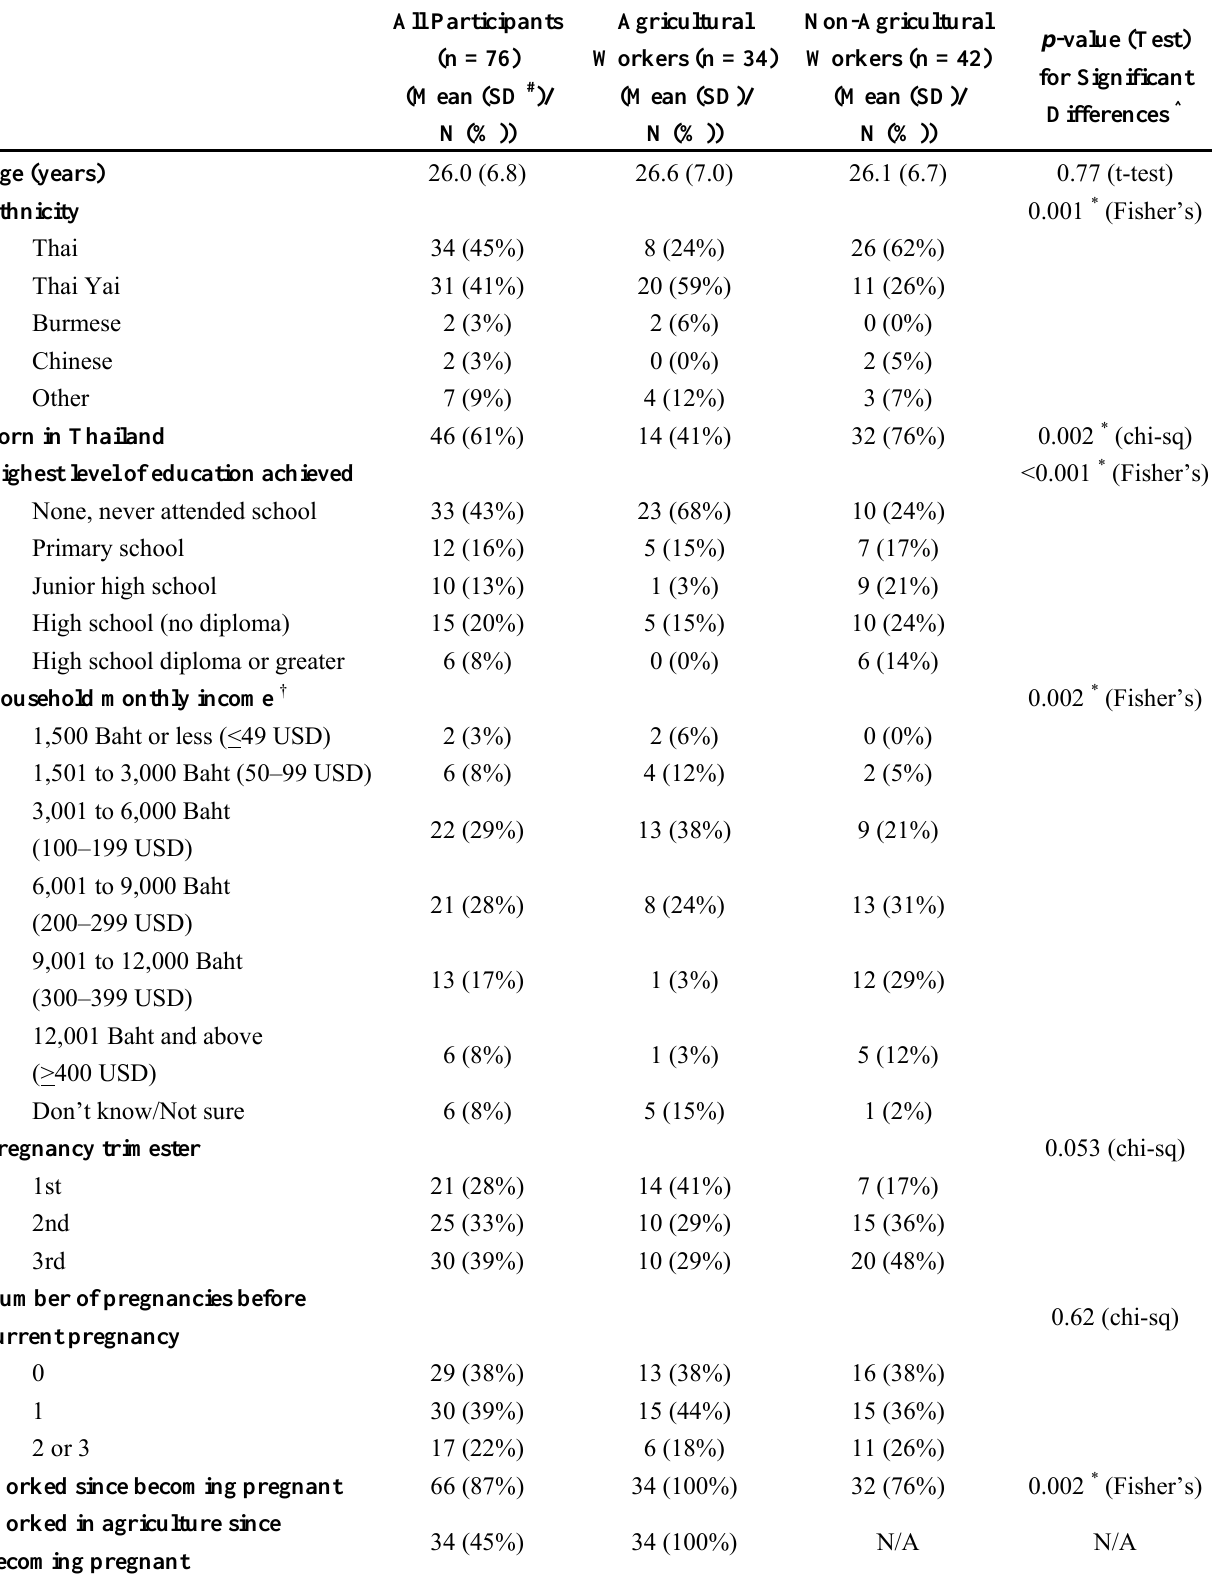
Table 1. Demographic characteristics of all participants and by